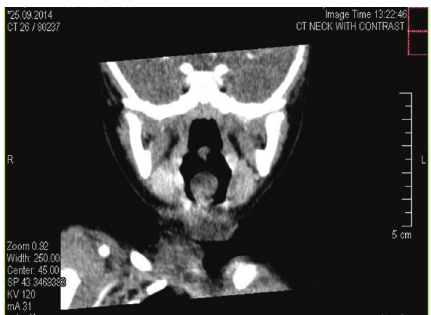
Figure 4: Coronal CT scan showing retroglossal fairly defined rounded nonenhancing hypodense cystic lesion measuring about 9 mm, seen projecting into oropharynx.